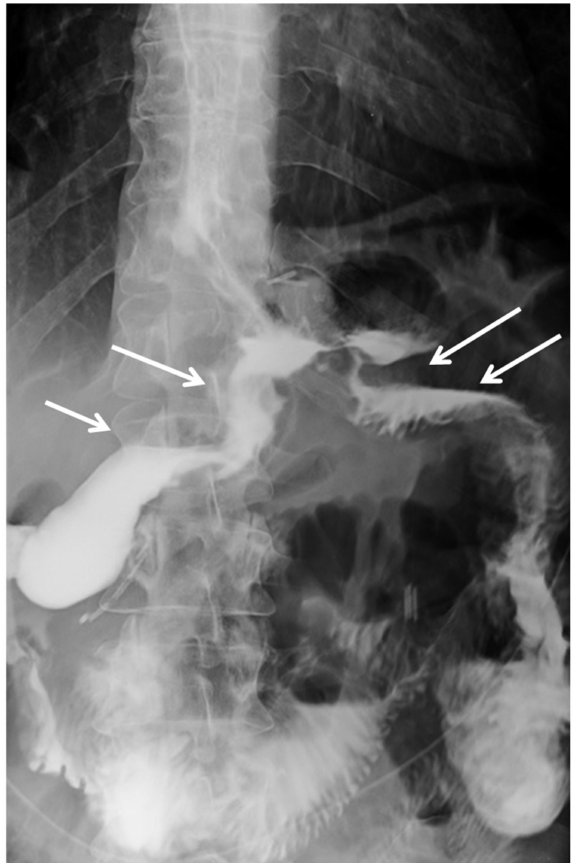
Figure 2. Post-operative upper gastrointestinal contrast. Normal contrast flow into duodenum (arrows) and through the gastro-jejunal bypass (arrows), without any stay of contrast material in the remnant